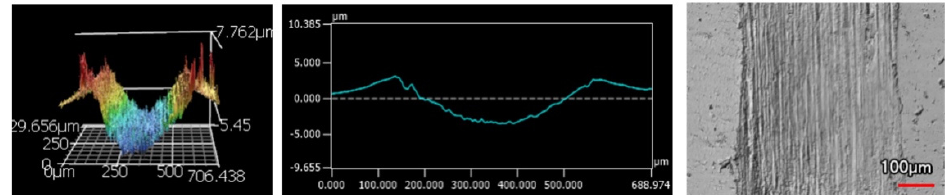
Figure 18. 9 μ m Thick Ni-P-NiTi Coating 100 Passes of the Spherical Indenter.